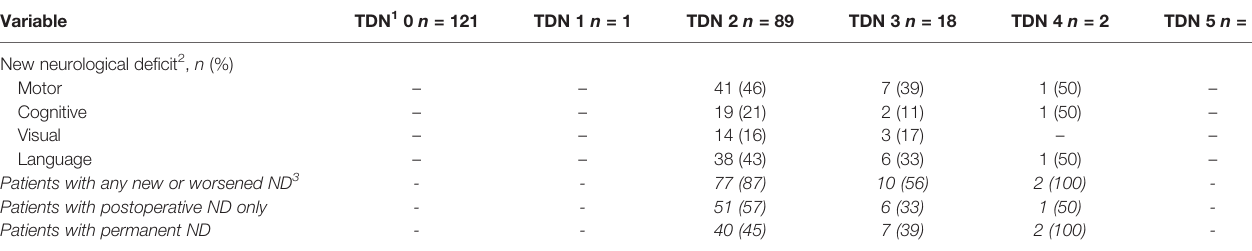
TABLE 4 | Neurological de fi cits at admission and follow-up in patients by TDN score ( N = 231). Variable